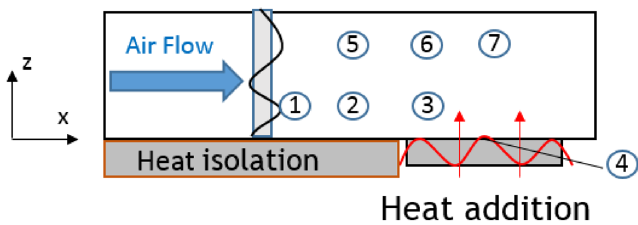
Fig. 6 Schematic process for temperature variation test from side view